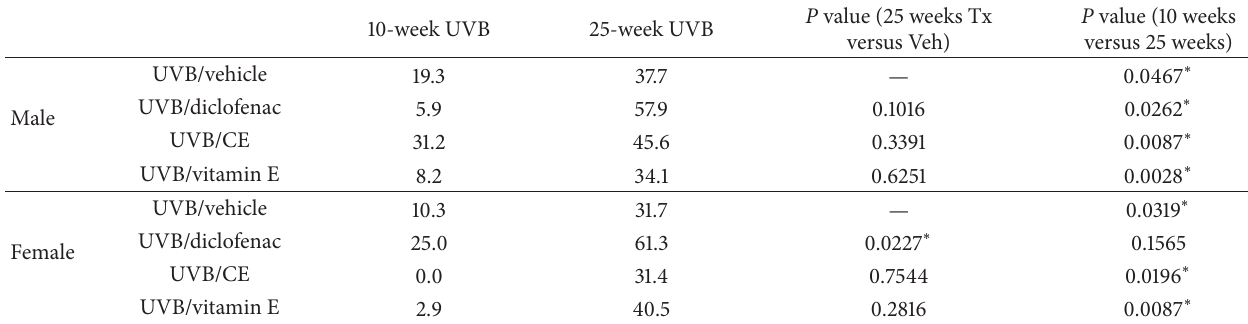
Table 1: Average percentage of malignant tumors per treatment group after 10 and 25 weeks of UVB exposure in male and female